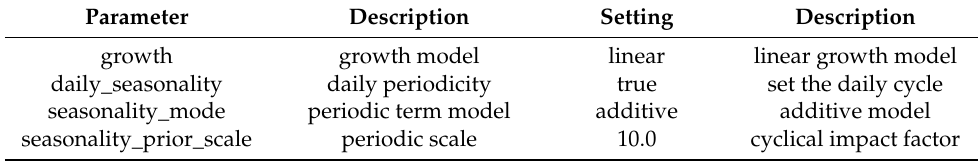
Table 1. Prophet model parameter